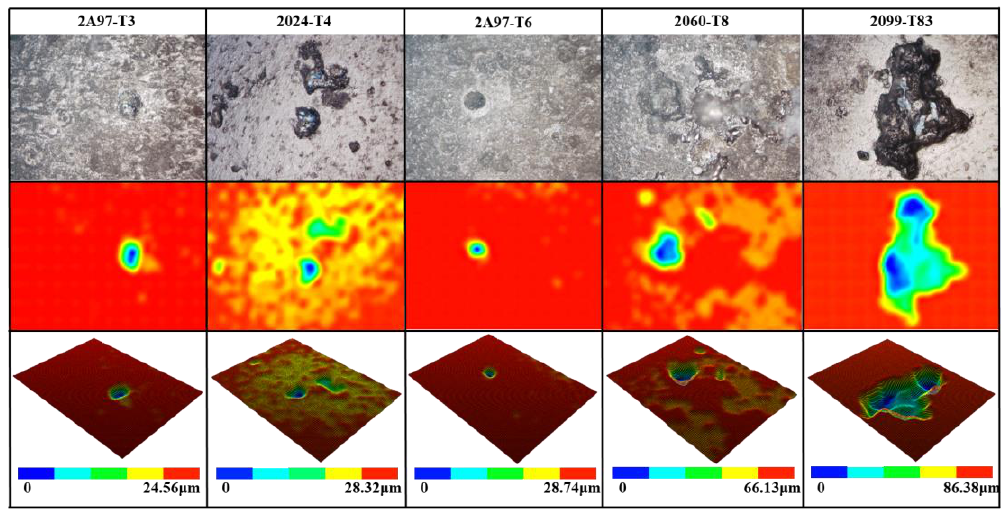
Figure 7. The corroded surface and 3D morphology of the test material after soaking in 3.5 wt.% NaCl solution for 28 days.